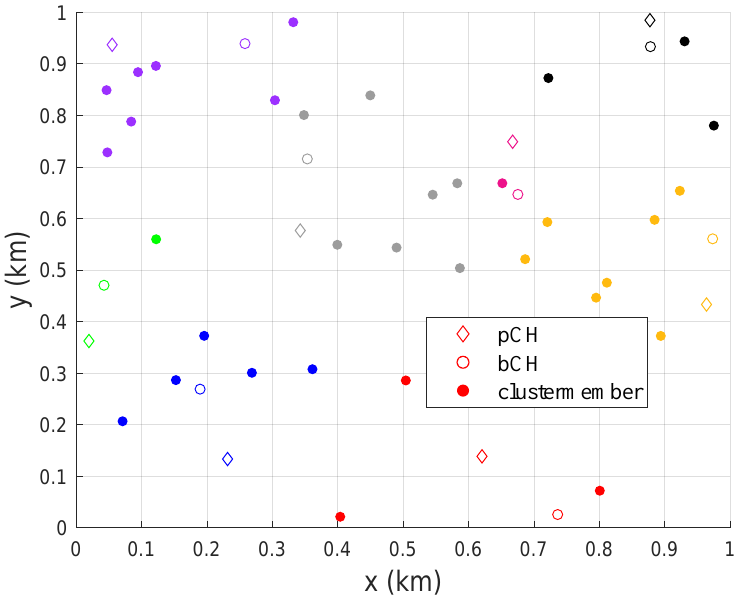
Figure 4. The distribution and clustering results of the UAVs. The nodes in the same cluster are shown in the same color. The label takes one of the clusters as